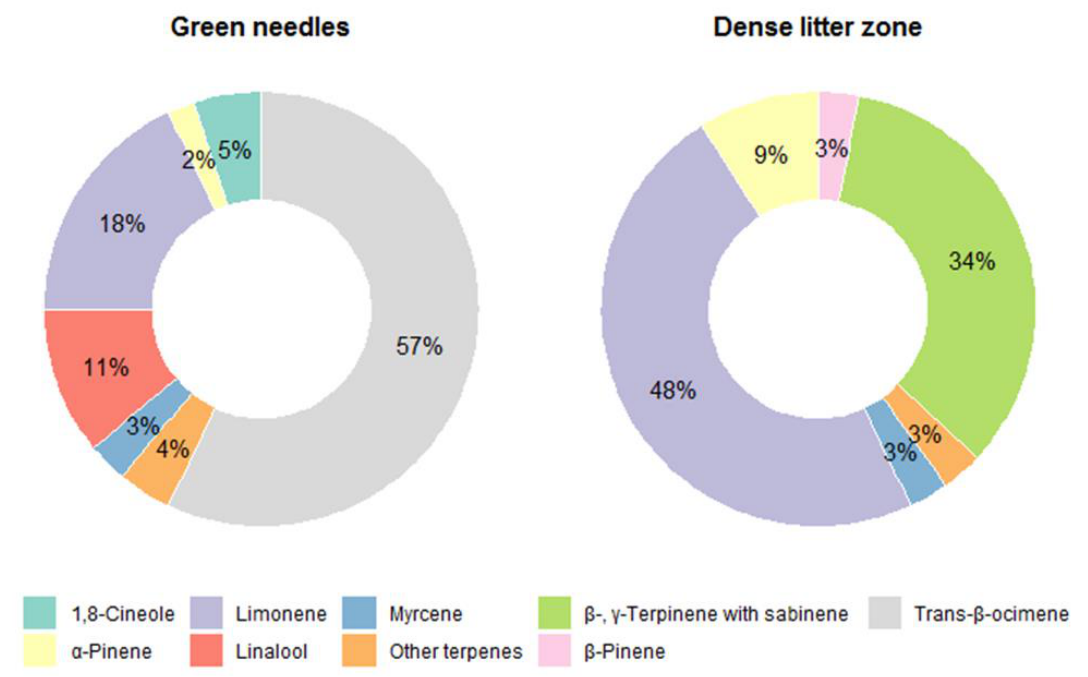
Figure 3. The composition of terpene emissions for green needles [36] and dense litter zone of our study ( ≤ 1 m) in summer mornings.